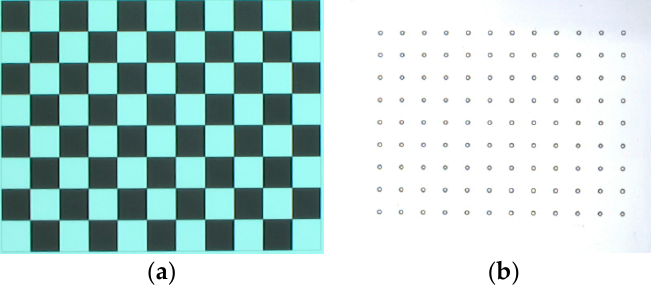
Figure 5. Photo of the calibration targets. ( a ) Checkerboard; ( b ) mirror with a hollow ring matrix pattern on its surface.